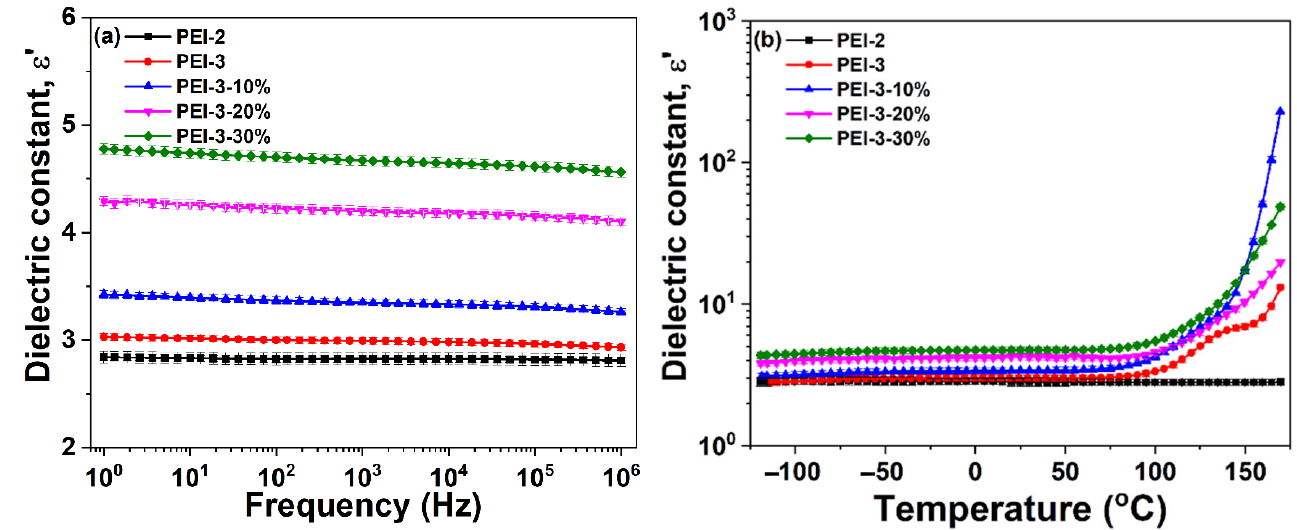
Figure 10. The evolution of dielectric constant with frequency at room temperature ( a ) and with temperature at 10 Hz ( b ) for the studied samples.